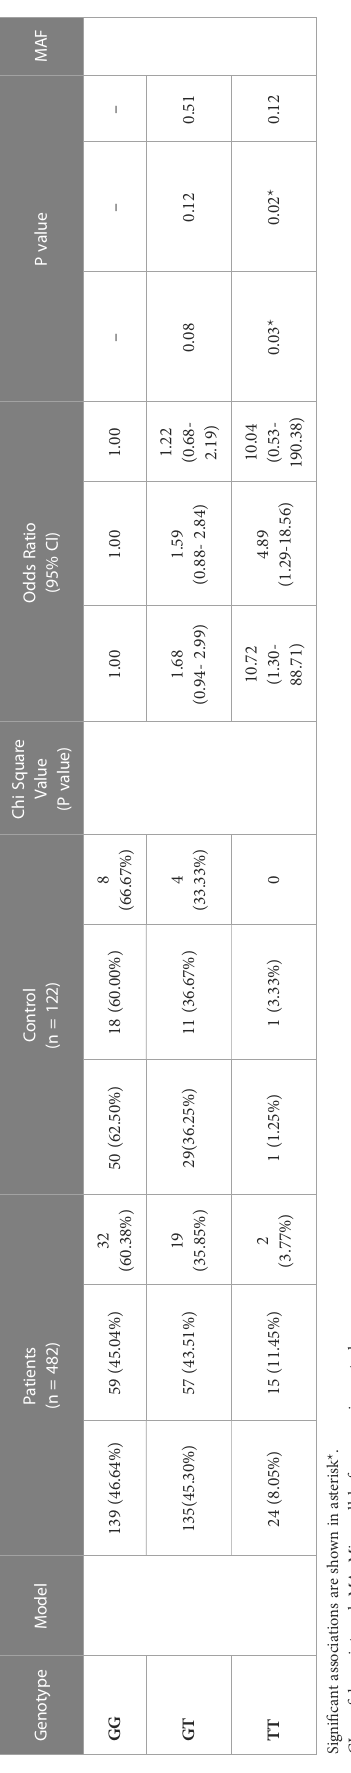
FIGURE 6 Intensity of SPT reactions in asthmatic patients bearing different genotypes of TBXA2R rs34377097 polymorphism. One-way ANOVA test revealed that individuals bearing TT genotype showed highest intensity of SPT reactions in terms of wheel diameter than GG and GTbearing individuals. (*P value signi fi